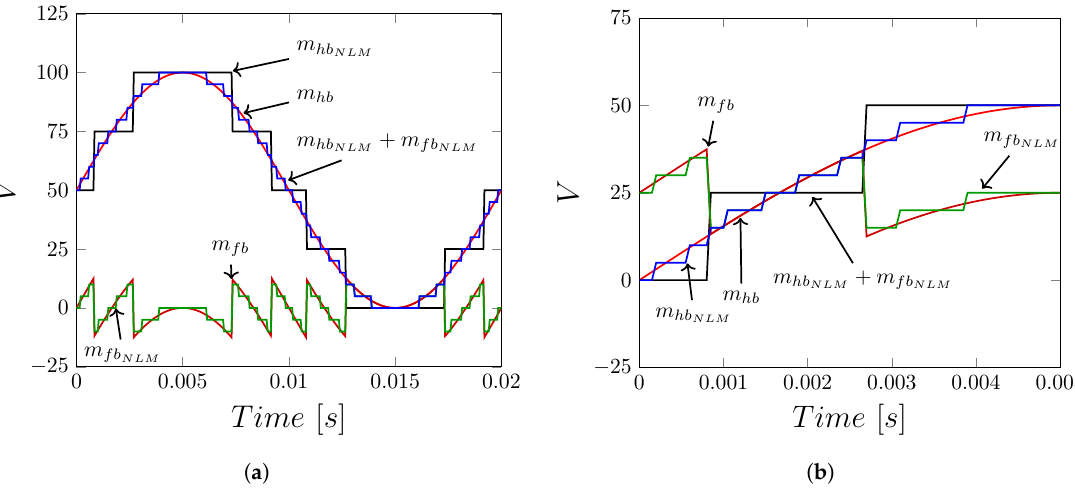
Figure 2. Phase representation of EMMC topology: ( a ) Operation during a full cycle and ( b ) detailed